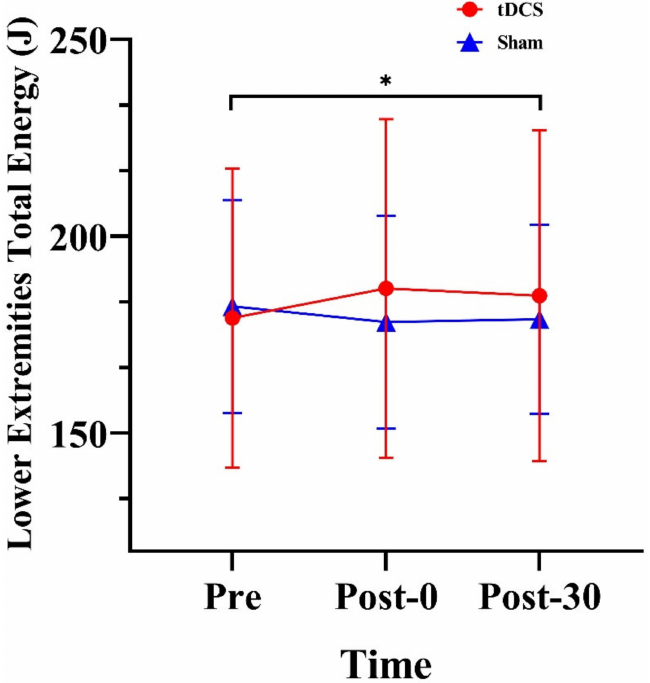
Figure 3. Effects of tDCS on lower limb net energy in CMJs. * indicates a significant difference between times, Pre: pre-stimulation, Post-0: post-0 min, Post-30: post-30 min.